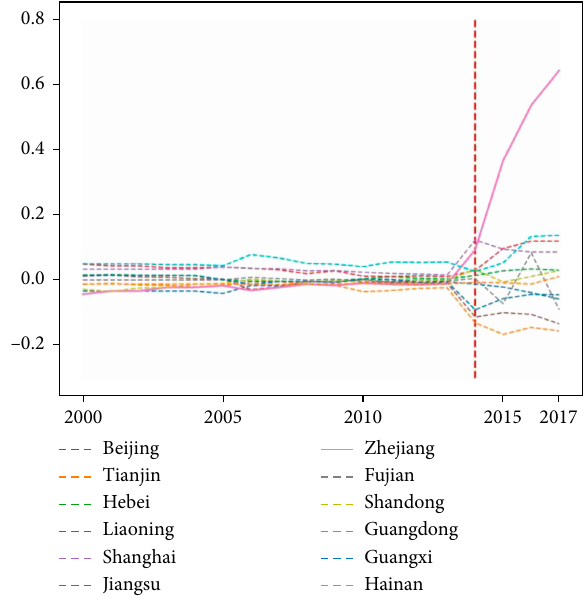
Figure 5: Placebo